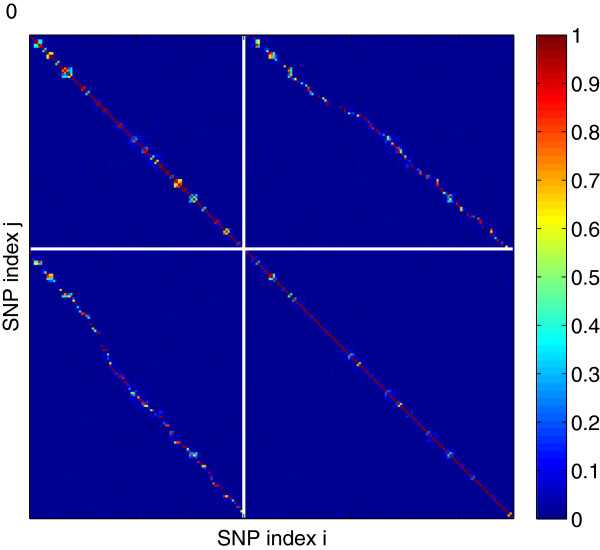
The matrix of correlations (positive roots of the r2 LD measure) among false positives and true nonzeros after the presumptive μP − valuephase transition for chromosome 22 (s = 125, n = 5, 000, and h2 = 0.5). SNP indices begin at the top left corner. The upper-left quadrant contains the correlations among false positives and the lower-right quadrant contains the correlations among the true nonzeros. Each element in the upper-right (lower-left) quadrant represents a correlation between a false positive and a true nonzero. Within both the false positive and the true nonzero sets, the markers are arranged in order of chromosomal map position.